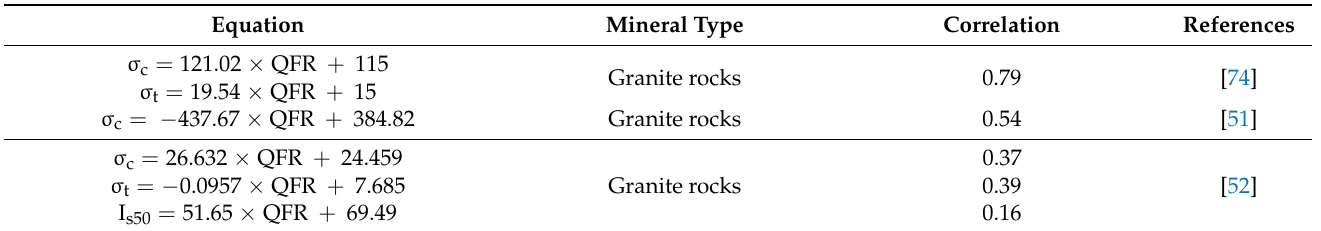
Table 10. Regression equations between mechanical properties and quartz-to-feldspar ratio ( σ c , I s50 , and σ t are in Mpa).